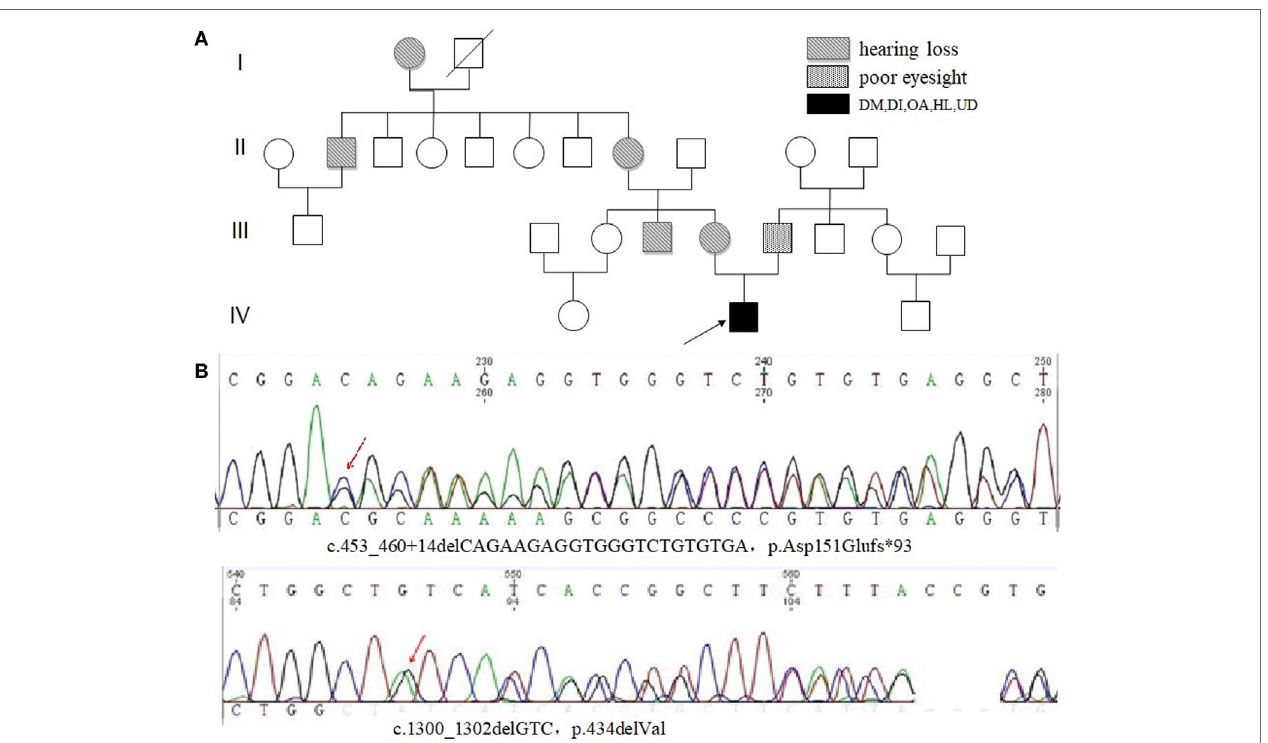
FigUre 3 | Family pedigree of Case 3 with Wolfram syndrome and the results of genetic analysis. (a) The proband (Subject IV-2) was indicated by a black arrow. HL or poor eyesight was present in some family members. (b) Sanger sequencing of genomic WFS1 DNA showed compound heterozygous mutations, p. Asp151Glufs*93 and p.434delVal in proband (Subject IV-2). Abbreviations: DM, diabetes mellitus; IGT, impaired glucose tolerance; OA, optic atrophy; DI, diabetes insipidus; HL, hearing loss; UD, urological